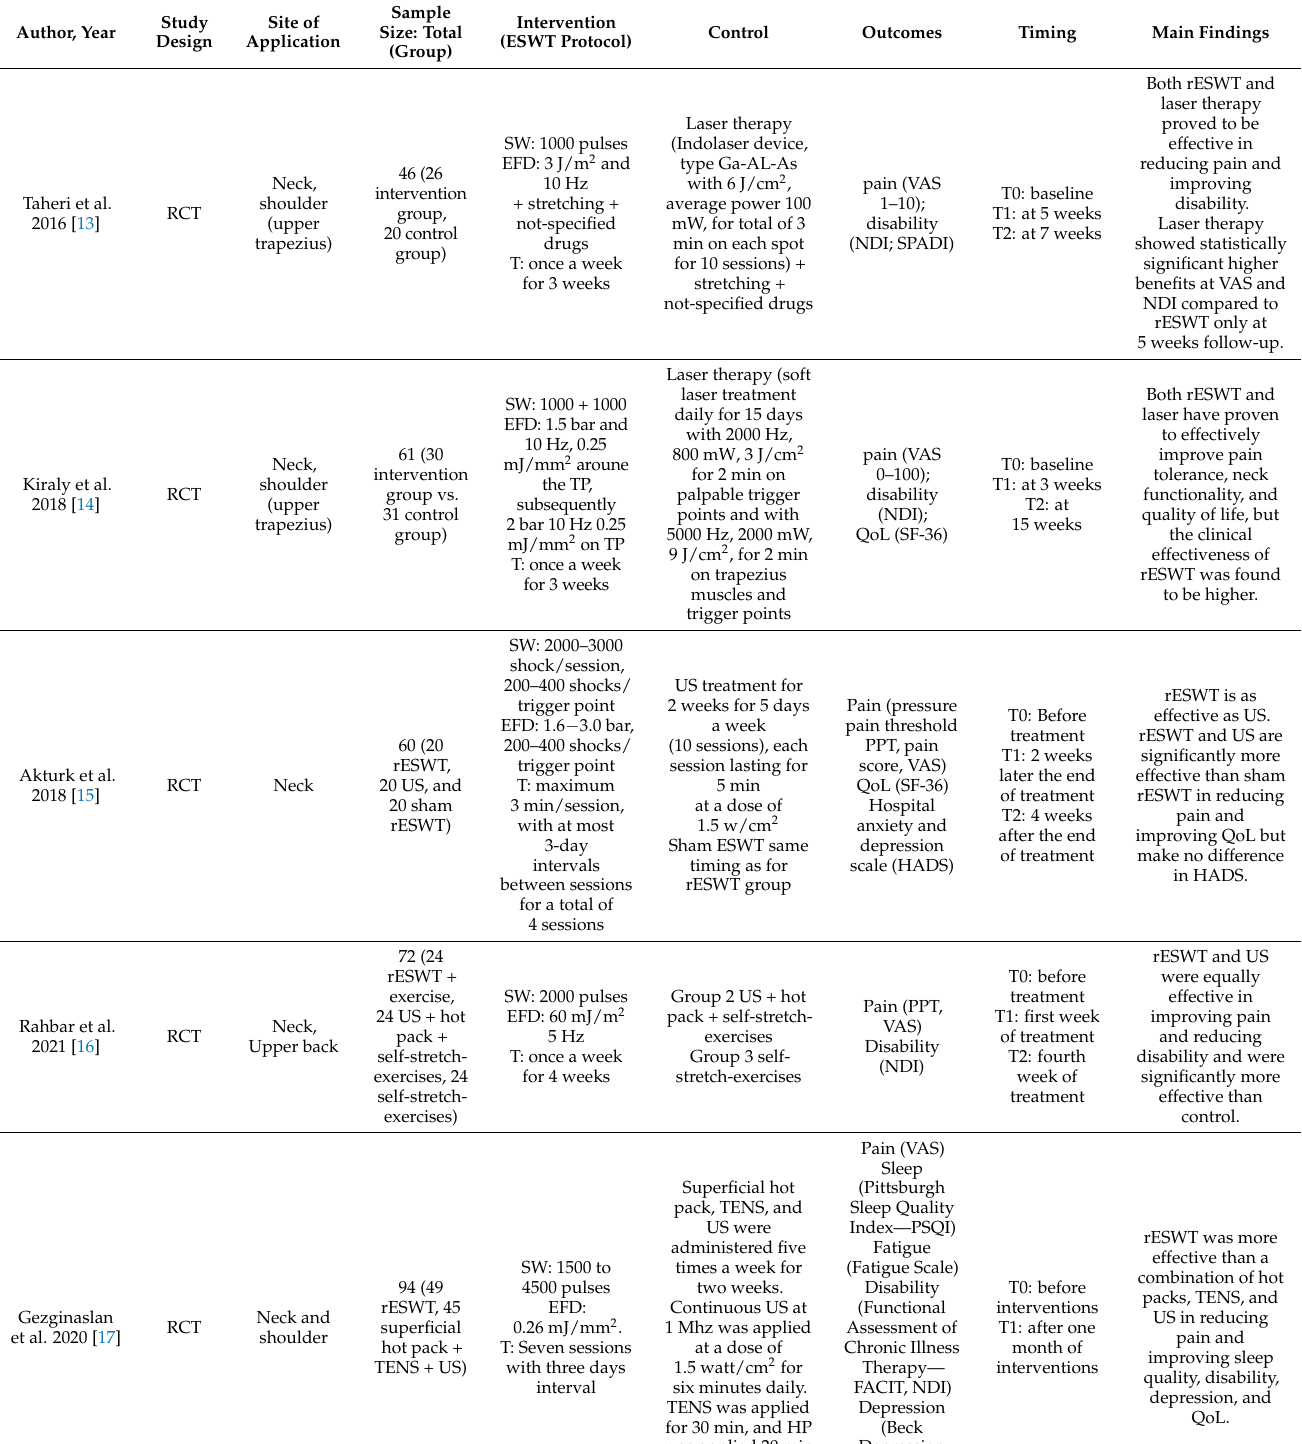
Table 3. Main characteristics and key findings of the included studies about Radial ESWT for myofascial pain